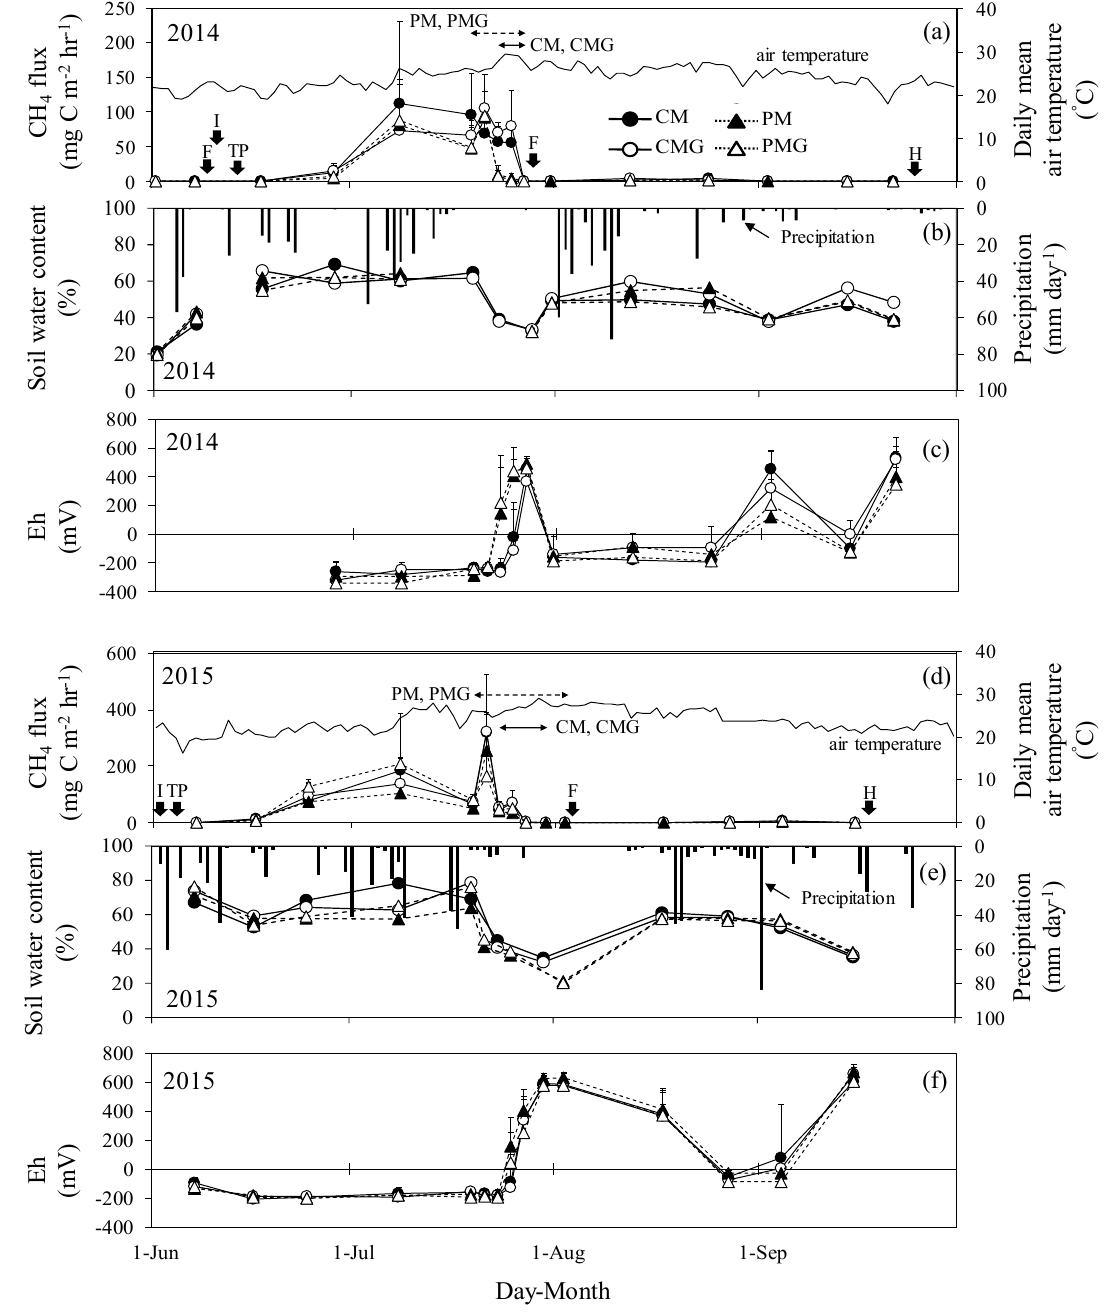
Figure 1. Seasonal variations in daily mean air temperature and CH 4 flux ( a , d ), precipitation and soil water content ( b , e ), and Eh ( c , f ) during the growing season. Error bars represent standard deviations. I, F, TP, and H represent irrigation, fertilization, transplanting, and harvest, respectively. Arrows of the continuous and dotted lines show the periods of mid-season drainage.